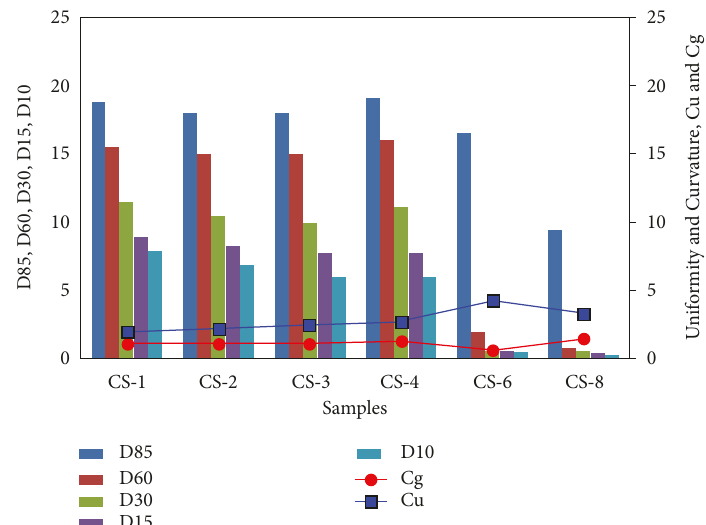
Figure 7: Sample coefficients based on compaction condition: uniformity and curvature.